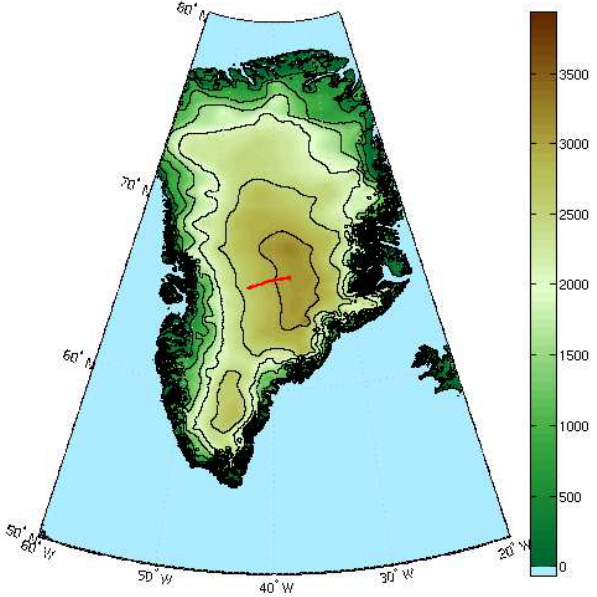
Fig. 1. The track of the 200km ASIRAS transect over the dry snow region of the GrIS. Contour lines represent 500m elevation inter-